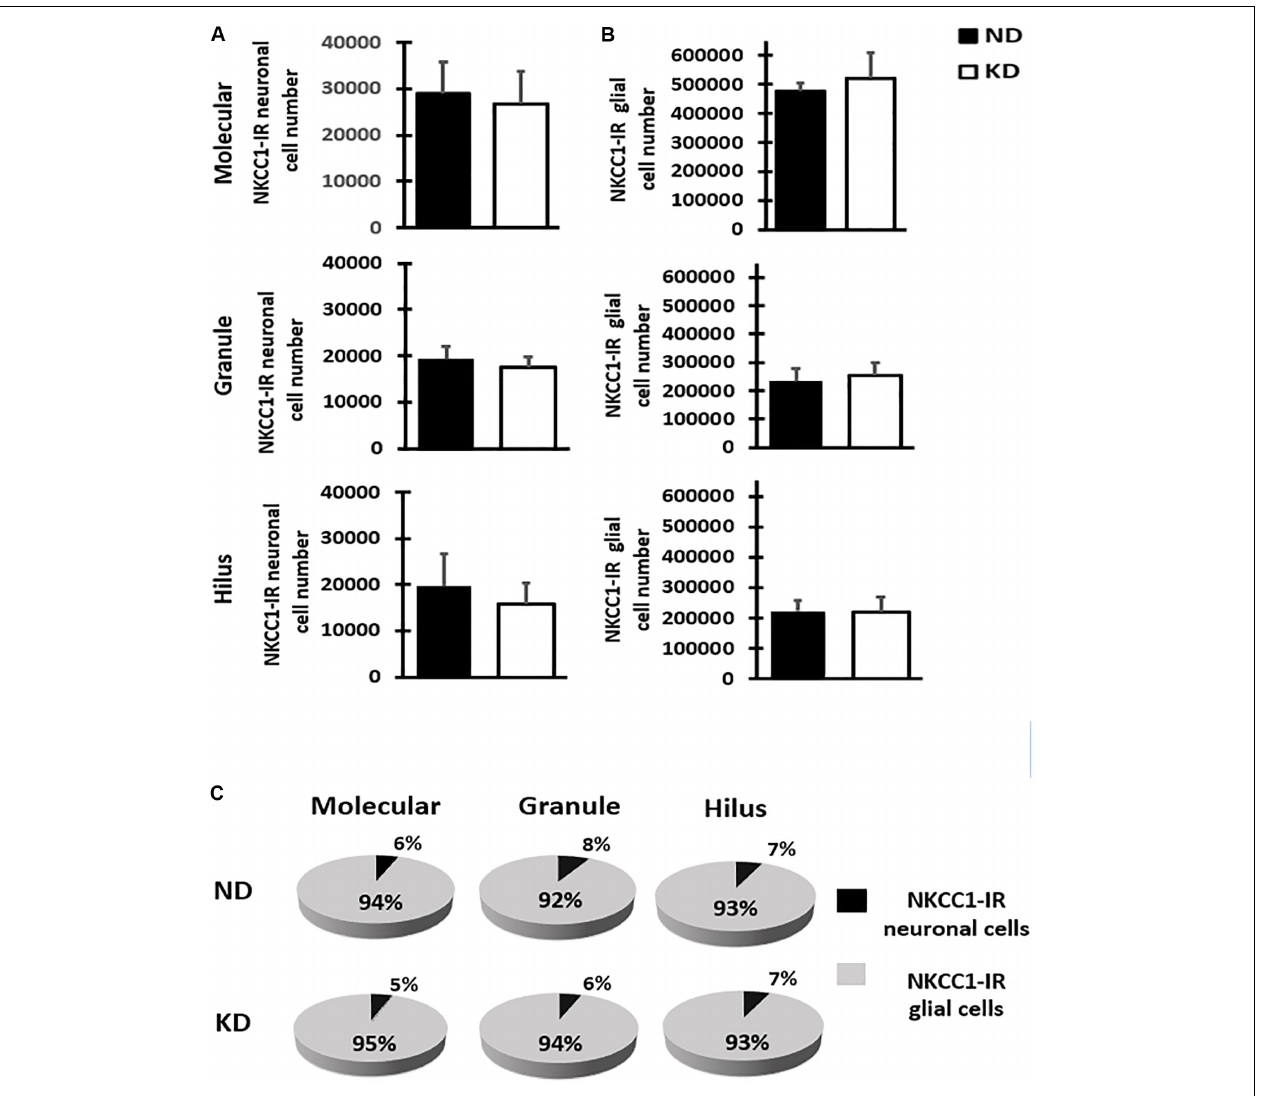
FIGURE 3 | Bar graphs show mean and SD of NKCC1-IR neuronal (A) and glial (B) cells number estimated by stereology in the three layers of dentate gyrus of rats fed with normal diet (ND) or ketogenic diet (KD), n = 8 in each group. The estimate of cell number showed that KD does not significantly change the NKCC1-IR neuronal or glial cell number when compared with ND rats in the molecular and granule layers, and hilus of the dentate gyrus. (C) Fractional composition of NKCC1-IR neuronal and glial cells in the three layers of dentate gyrus in control group (ND) and ketogenic group (KD). The data are presented as a percentage of total of NKCC1-IR neuronal and glial cells in each